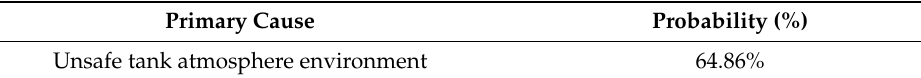
Table 5. Probabilities of primary cause.